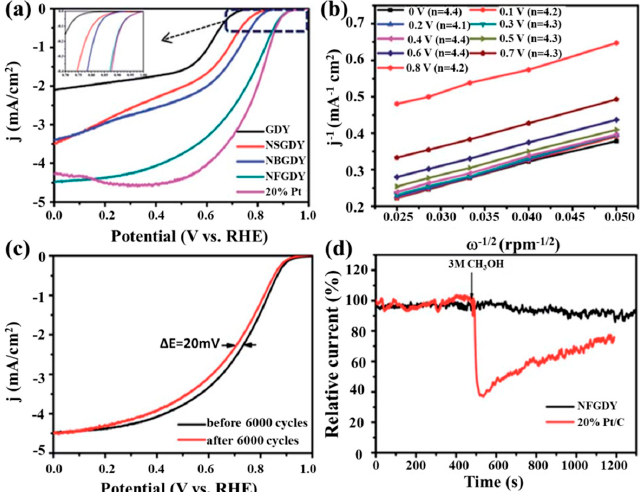
Figure 15. ORR electrochemical characterizations of polyatomic co-doped GDY. ( a ) LSV curves of GDY, NSGDY, NBGDY and NFGDY obtained from RDE measurements at 1600 rpm at a scan rate of 10 mV s − 1 in O 2 -saturated 0.1-M KOH; ( b ) Koutecky–Levich (K–L) plots of NFGDY calculated at di ff erent potentials; ( c ) stability tests of NFGDY at 1600 rpm before and after 6000 continuous CV cycles from − 0.05 to 1.15 V (vs. RHE) at a scan rate of 200 mV s − 1 ; ( d ) methanol-tolerance evaluation of NFGDY tested by the current–time chronoamperometric responses (20% Pt / C is used for comparison) (reproduced with permission from [79]. Copyright The Royal Society of Chemistry,